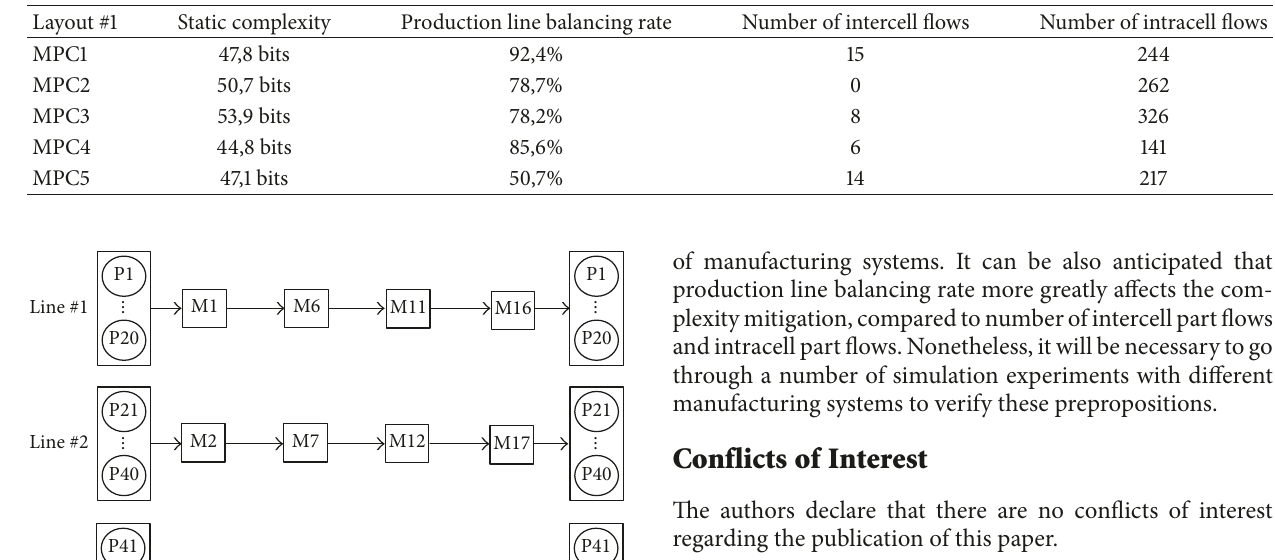
Table 16: Comparison of indirect indicators with static complexity measure.